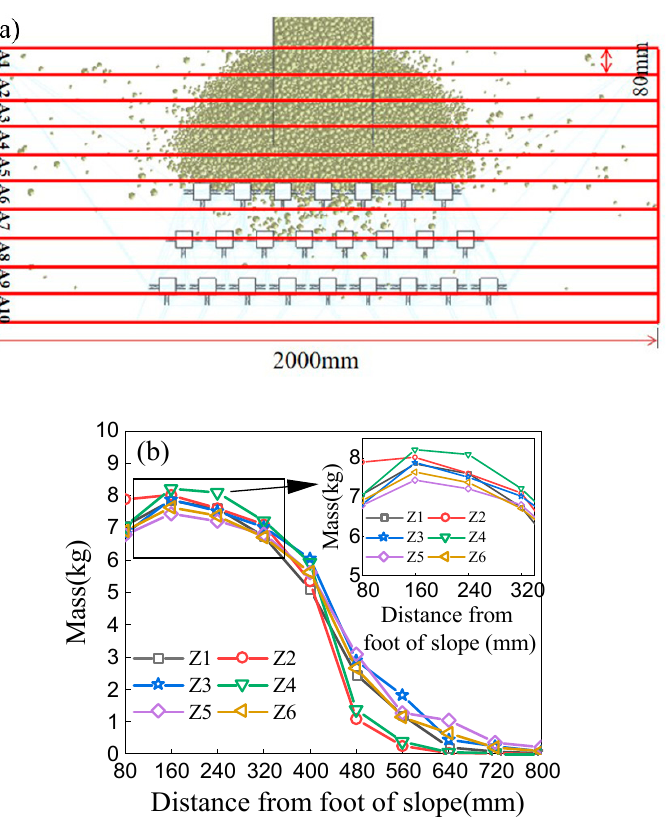
Figure 18. The influence of baffle type on baffle mass distribution: ( a ) schematic plan of mass calculation in the baffle area, ( b ) influence of baffle type on mass distribution in the baffle.